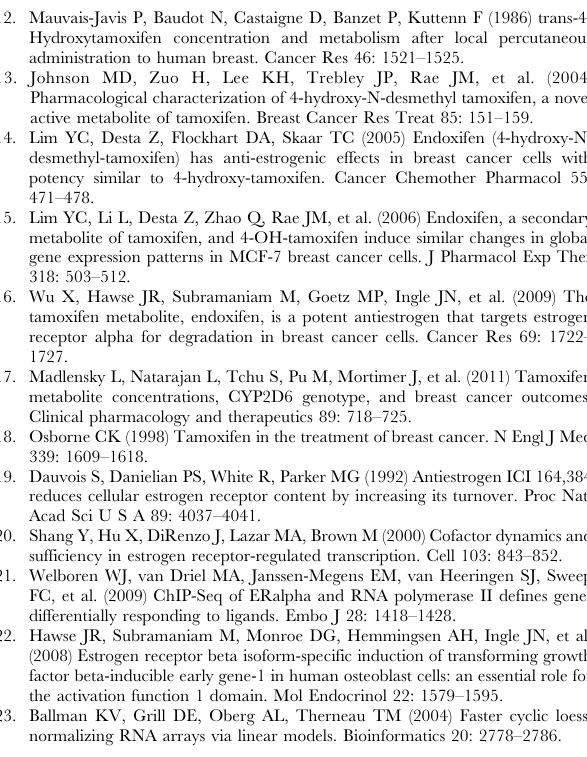
Table S2 Genes determined to be significantly altered by the addition of an anti-estrogen + estrogen relative to estrogen treatment alone. Table S3 Genes determined to be significantly regulat- ed by estrogen + 4HT, estrogen + endoxifen or estrogen + ICI, but not by estrogen treatment alone. Table S4 Genes determined to be significantly regulat- ed by 24 hour treatments with 100 nM concentrations of 4HT, endoxifen or ICI relative to vehicle controls. Table S5 Genes determined to be significantly regulat- ed by the addition of various endoxifen concentrations relative to cells treated with estrogen (10 nM), tamoxi- fen (300 nM), NDT (700 nM) and 4HT (7 nM) alone.